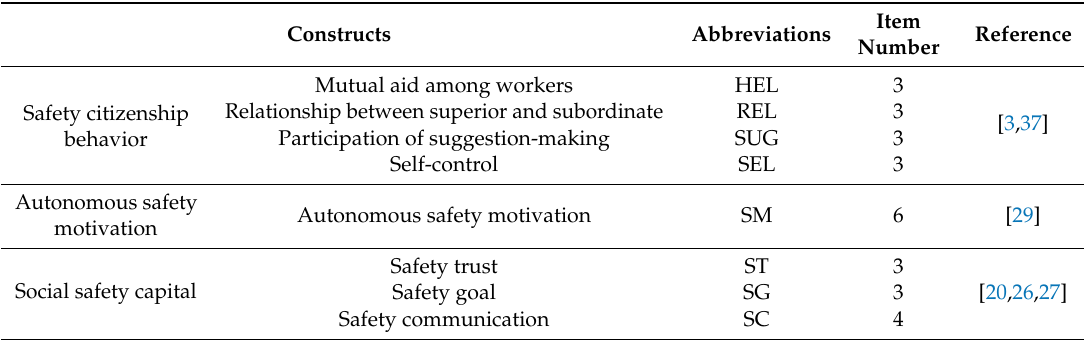
Table 2. The sources of